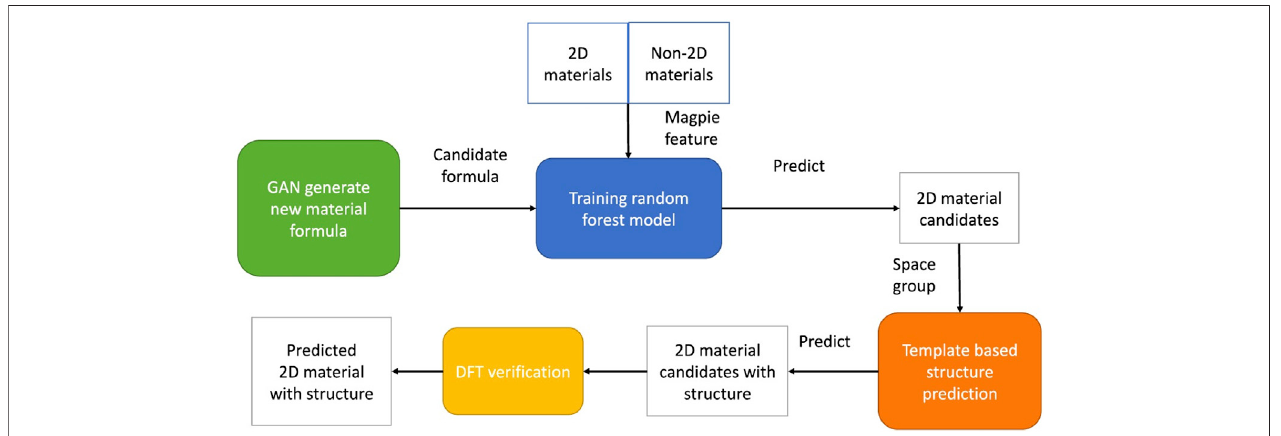
FIGURE 6 | Four components of 2D material generation using MatGAN. The green box represents MatGAN generation of new materials, and the blue box representstherandomforestclassi fi er.Theorangebox(template-basedelementsubstitution) andyellowbox(DFT)arevalidationsteps.Reprinted withpermission from Song et al. (2021).